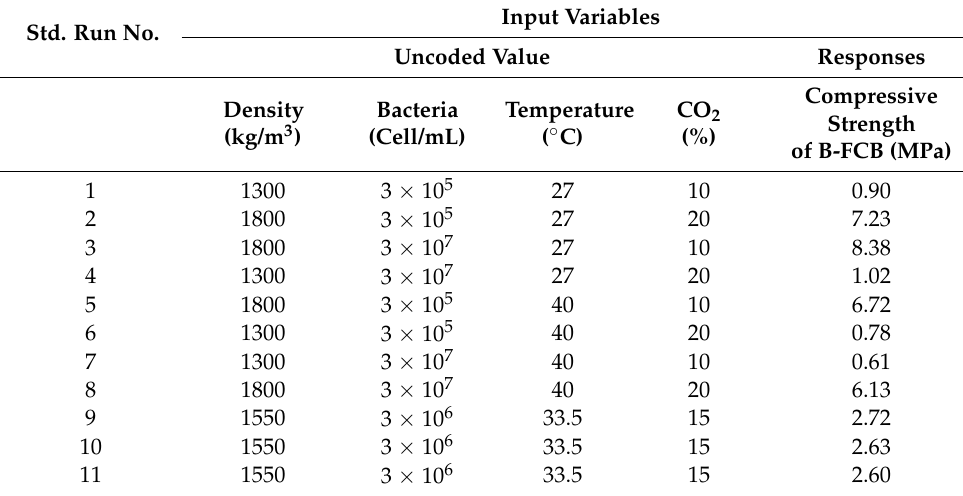
Table 5. Compressive strengths of all samples in the screening stage.